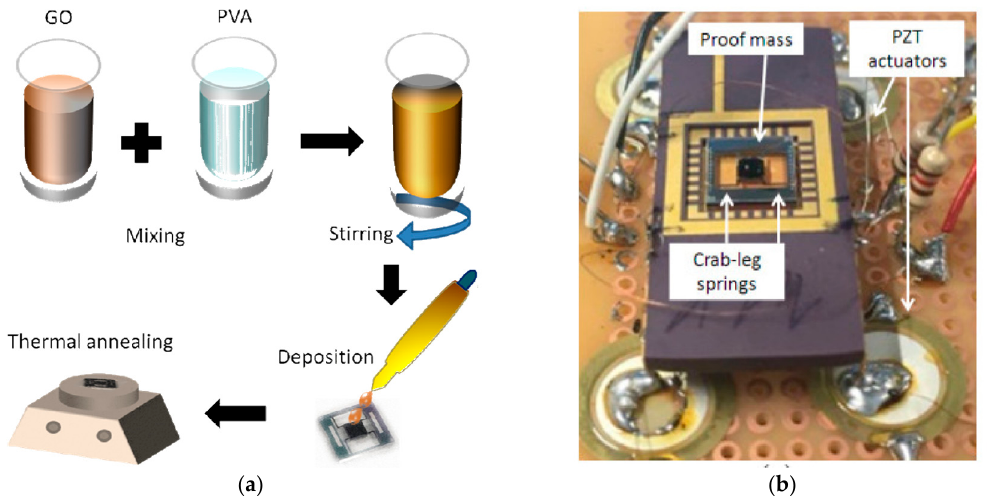
Figure 1. Sensor fabrication: ( a ) GO/PVA composites preparation by solution mixing and deposition on the micromachined sensor and ( b ) realized microsensor and four PZT elements used to move the